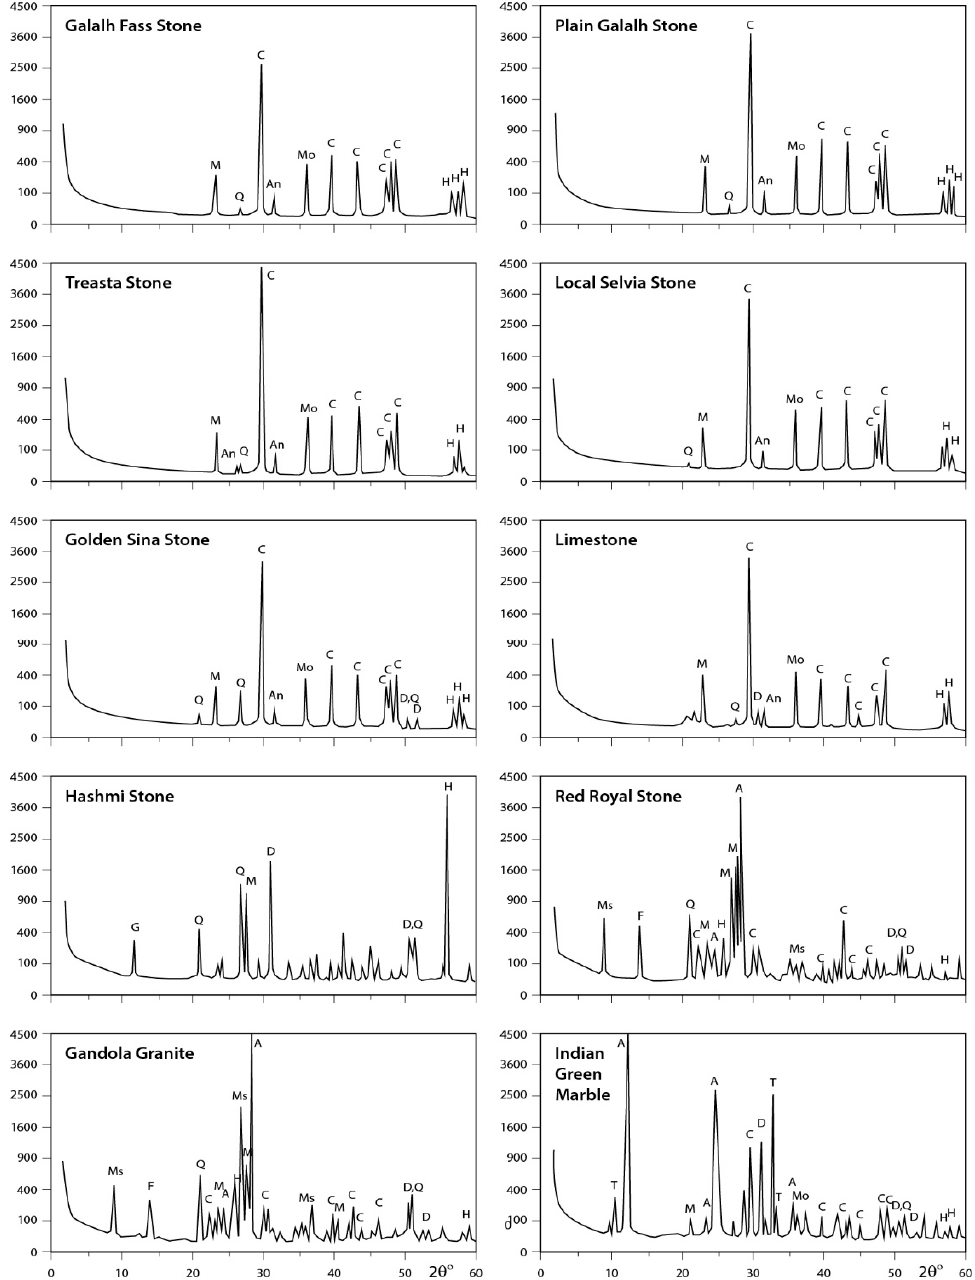
Figure 8. XRD profiles for the analyzed samples. The identified minerals are: A = albite; An = anhydrite; At = antigorite; C = calcite; D = dolomite; F = feldspar; G = gypsum; H = halite; I = illite; K = kaolinite; M = microcline; Mo = montmorillonite; Ms = muscovite; O = orthoclase; Q = quartz; T =